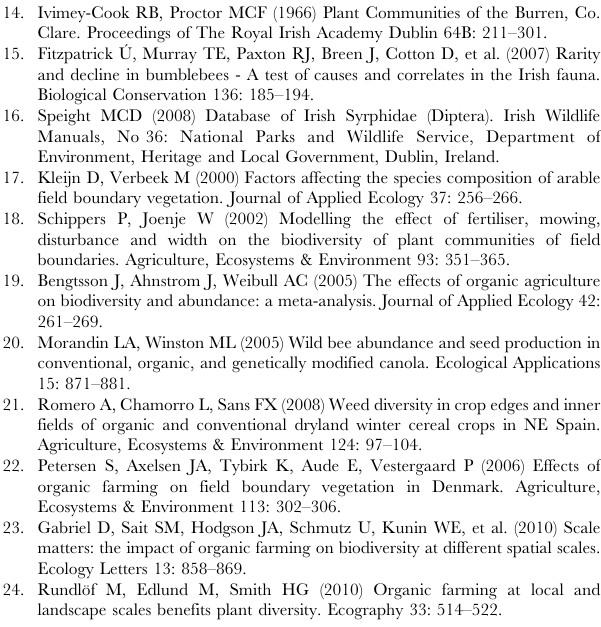
Figure S1 Percentage cover of unimproved grassland around each study site (farm pairs 1–10) for each of five spatial scales (1–5 km radii around sites).